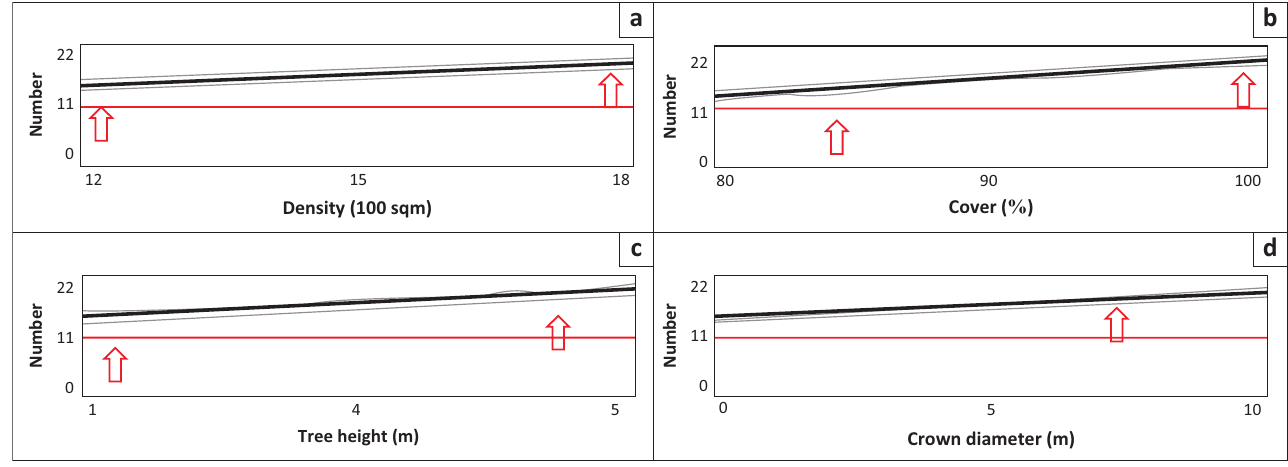
Red arrows = a higher precision of uncertainty. FIGURE 5: Al Mudhaylif demographic features sensitivity analysis: (a) Density (100 m 2 ); (b) Cover ( % ); (c) Tree height (m); (d) Crown diameter (m); (e) Number of dead trees (100 m 2 ); (f) Number of seedlings (100 m 2 ); (g) Number of respiratory roots (100 m 2 ) and (h) Average height of respiratory roots